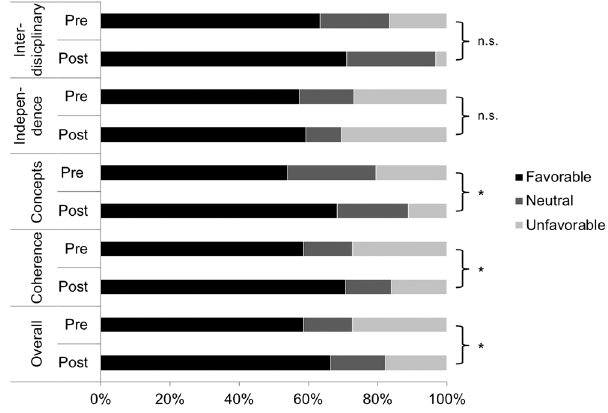
FIG. 1. NEXUS/Physics MPEX II responses for matched students ( n ¼ 9 ) in Fall 2012 semester. Asterisk indicates p < 0 . 05 . Wilcoxon signed-rank test (two-tailed) for overall (28 items), S ¼ 1906 , p ¼ 0 . 02 ; coherence (11 items), S ¼ 582 , p ¼ 0 . 002 ; concepts (7 items), S ¼ 418 , p ¼ 0 . 0003 ; independence (12 items), S ¼ − 221 , p ¼ 0 . 33 ; interdisciplinary (10 items), S ¼ 150 , p ¼ 0 . 45 .